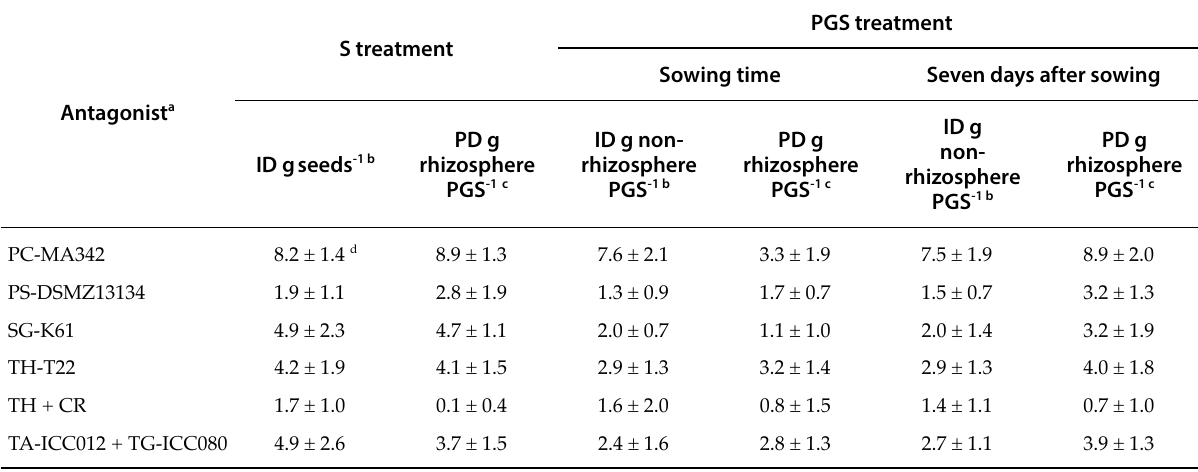
a Active microbial ingredients of Cedomon, Proradix, Mycostop, Rootshield, Clonotry and Remedier, respectively. b ID was determined as colony forming units (cfu) of antagonists by serial dilutions from treated S and PGS soon after the treatment. c PD was determined as for ID, but at the end of the experiment. d All data are expressed as Log cfu g seed -1 or Log cfu g PGS -1 , and represent means of two independent experiments ± standard